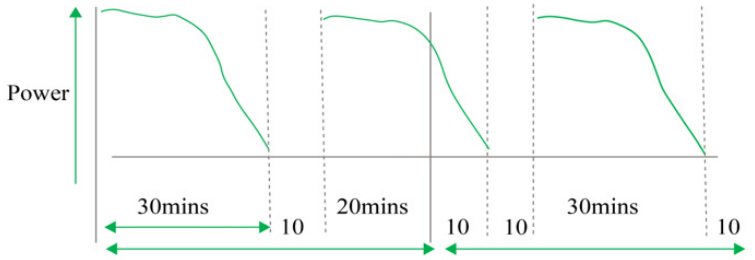
Figure 11 highlights 39.92 kWh delivery for three iD3 EVs charging consecutively, allowing a 10 min changeover period.